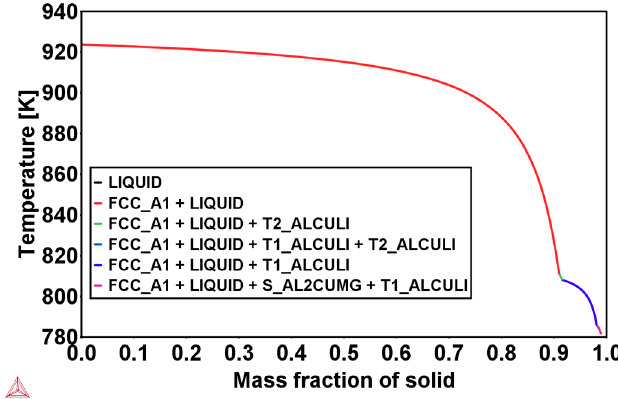
Figure 9. Scheil calculation using the database TTAl8 in Thermo ‐ Calc software for Al ‐ 2.63Cu ‐ 1.56Li ‐